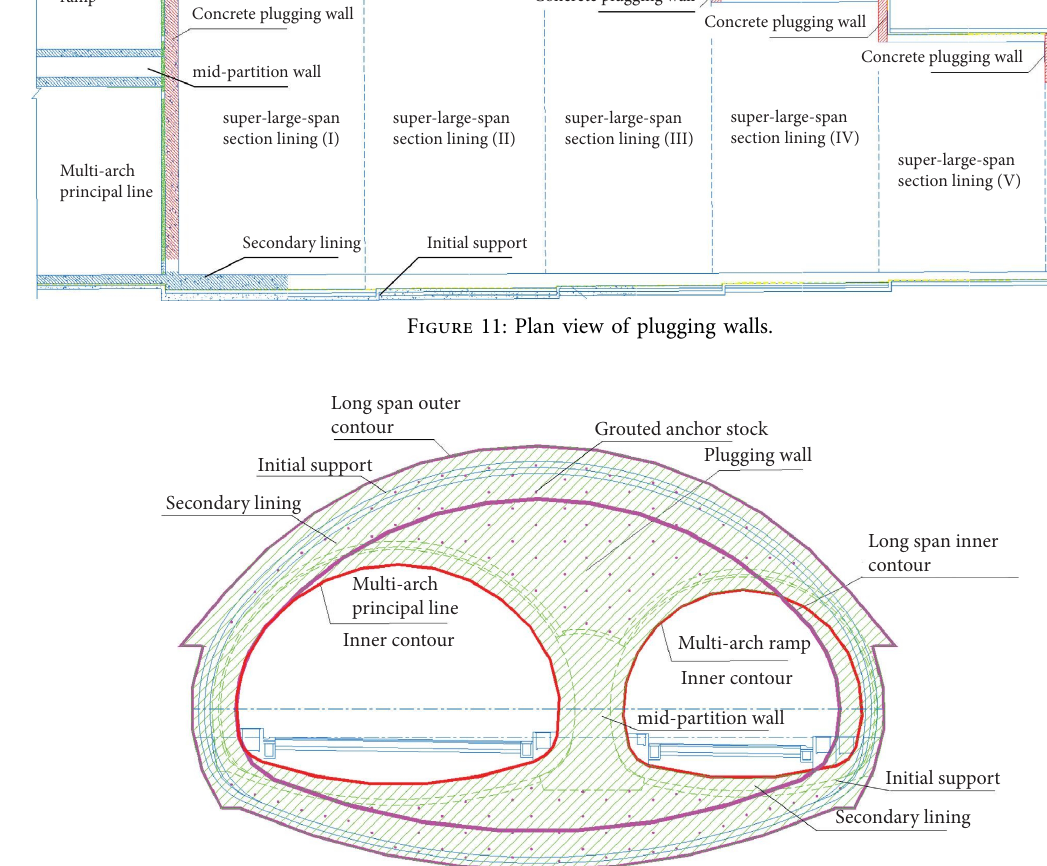
Figure 12: Sectional view of plugging wall at transit between multiarch section and long-span